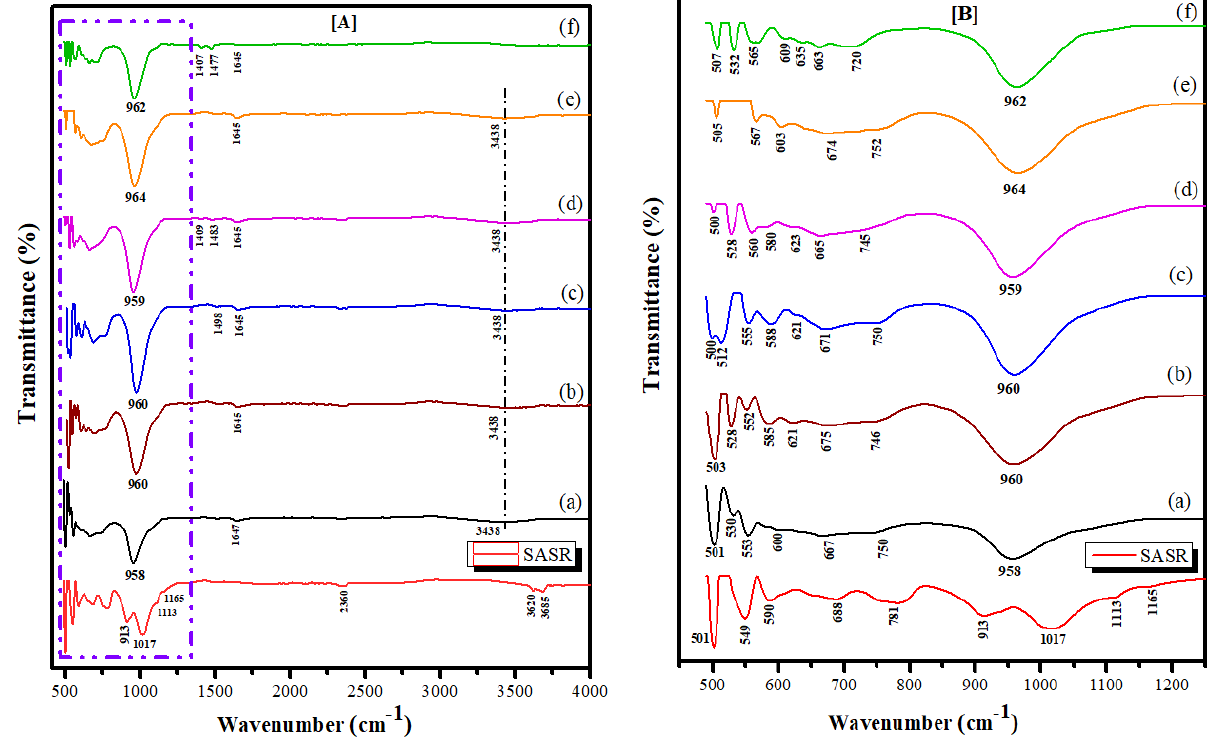
Figure 3. FTIR spectra of synthesized zeolite produced from SASR-Kaolin mixture at weight ratios of (a) 1:0, (b) 1:2, (c) 1:1.5, (d) 1:1, (e) 2:1, and (f) 0:1 ( A ), and detailed FTIR spectra in 1250–500 cm −1 wave number region ( B ).